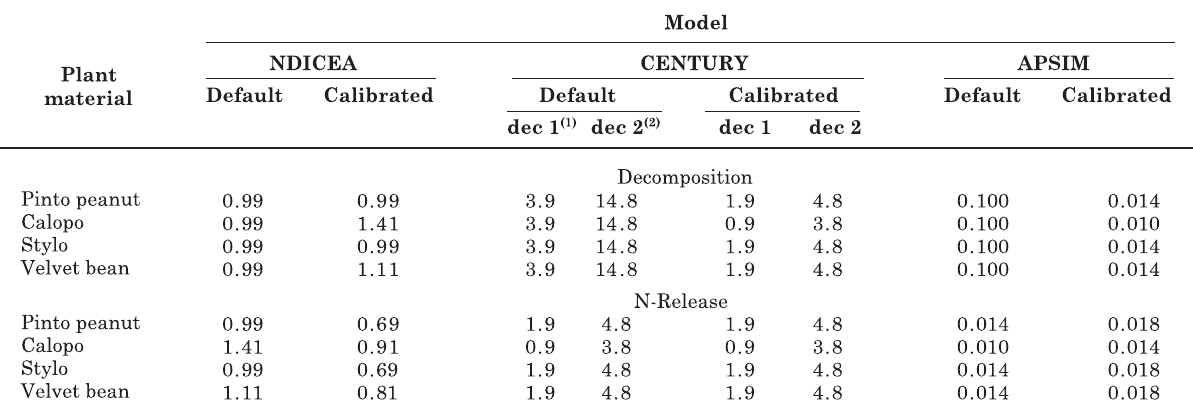
Figure 1. Dry matter and remaining N as a function of time (360 days) observed for residue of velvet bean (a and c) and calopo (b and d, respectively) and simulated by NDICEA, CENTURY and APSIM at the default settings. The bars at the measurement points correspond to the confidence interval (5 %) for the observed average. The percentage is the average deviation, calculated using Equation Table 4. Variables controlling the decomposition rate in models at default values and calibrated for the different plant residues after 360 days of decomposition (municipality of Pedra Dourada – Minas Gerais State)